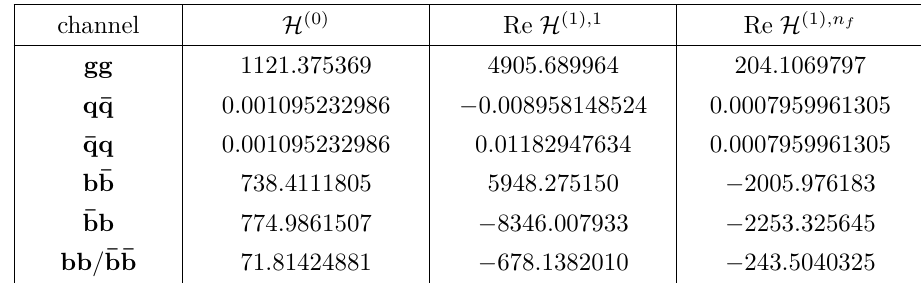
Table 7. Numerical values of the tree-level reduced squared amplitudes H (0) and one-loop reduced squared finite remainders H (1) defined in eqs. (6.3)–(6.9) at the kinematic point in eq. (6.11) for the closed fermion loops contributions and the scattering channels specified in eq.